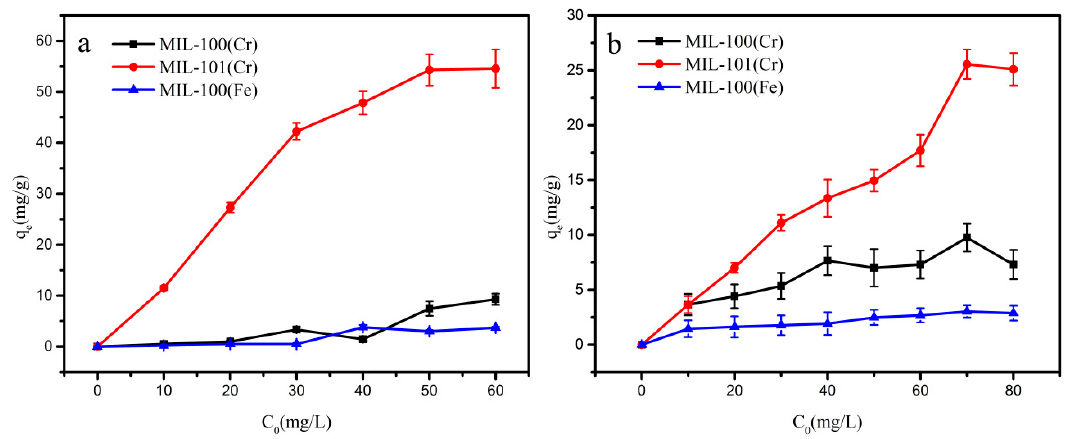
Figure 6. Adsorption isotherms for ( a ) 2-nitroaniline and ( b ) 2-amino-4-nitrotoluene adsorption on MIL-100(Fe) (blue), MIL-100(Cr) (black) and MIL-101(Cr) (red).